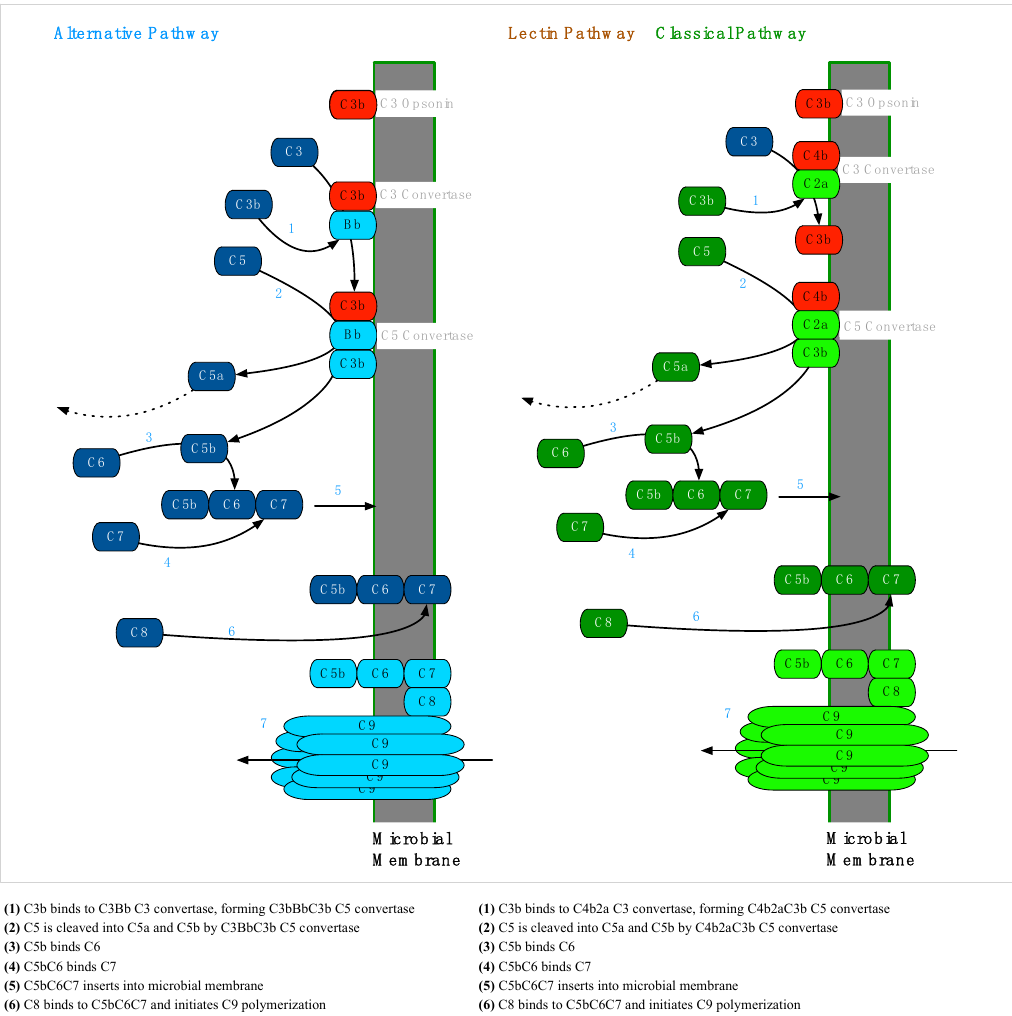
Figure 7. Membrane Attack Complex Formation via the Alternative, Lectin and Classical Complement Pathways—The formation of membrane attack complexes (MACs) is initiated when a membrane-bound C5 convertase cleaves soluble C5 into C5a and C5b. C6 and C7 bind C5b and the resulting C5bC6C7 complex, which is hydrophobic at the C7 end, embeds in the membrane. The MAC polymerizes when C8 binds C7, which induces the addition of several C9 molecules, forming a pore with a hydrophilic center that begins to lyse the cell. C5 convertases of the alternative pathway are formed by an additional C3b molecule joining a membrane-bound C3bBb C3 convertase, forming C3bBbC3b. In the lectin and classical pathways, the C3 convertase C4b2a is joined by C3b to form C4b2aC3b, which serves as the C5 convertase [37] .